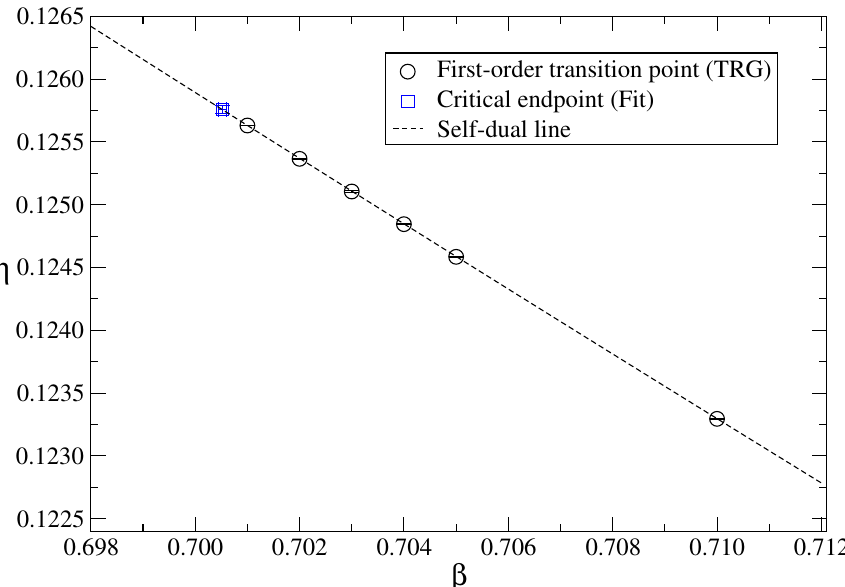
Figure 6 . Phase diagram in the vicinity of the critical endpoint. Circles show the first-order phase transition points and the critical endpoint is denoted by the blue symbol. Error bars are all within the symbols. Dotted line is the self-dual line defined by eq. (3.2) at which all transition points are